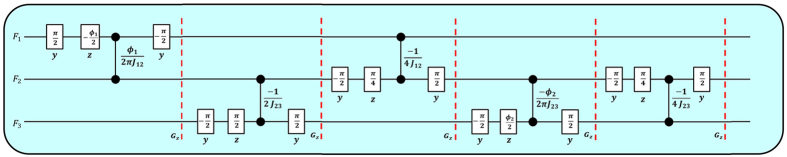
Pulse sequence for the initial state preparation.The initial state was prepared using Controlled-transfer gates methods. The boxes indicate the pulses that implement rotations applied to invidual qubits. The angles and phases of these rotations are indicated inside and below the boxes, respectively. Refocusing pulses are not shown. The free evolutions are represented by black dots connected by lines where the interaction of the two qubits, indicated by the dots, took place, for the time shown in the figure. The dotted red lines indicate when the field gradients were applied. ϕ1 = 98.2° and ϕ2 = 135.59°.